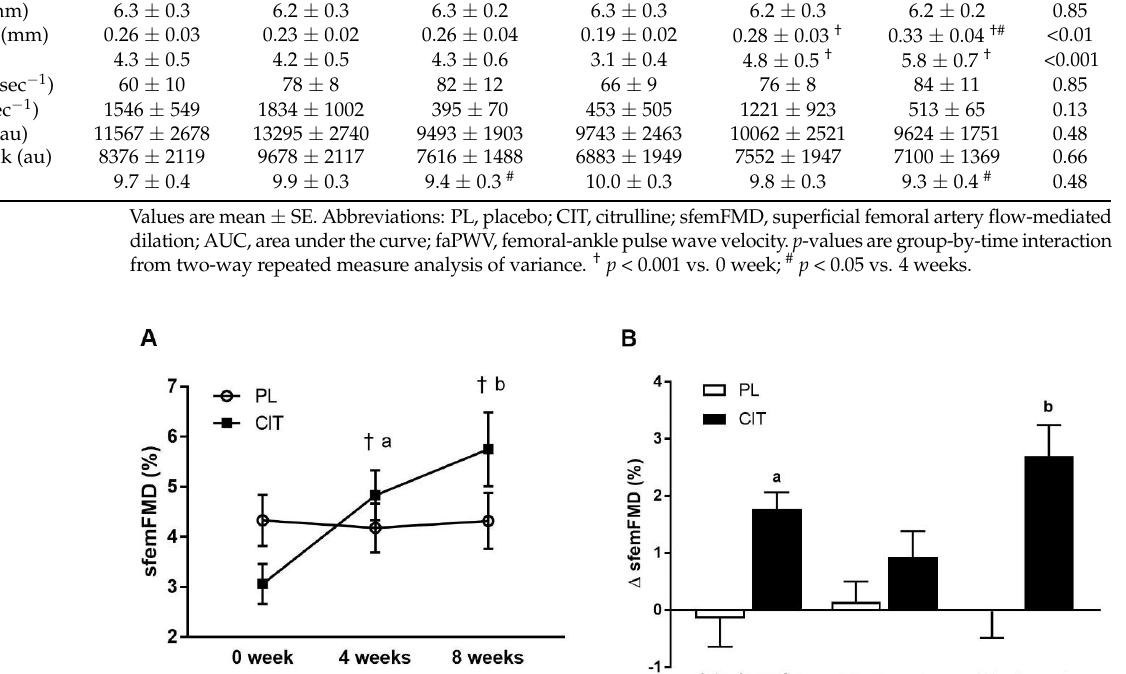
Figure 3. Superficial femoral artery flow-mediated dilation (sfemFMD) ( A ) at 0 week, after 4 weeks (CIT alone), and after 8 weeks (CIT and SVLIRT combined) and changes (Δ) in sfemFMD ( B ) from 0 week to 4 weeks, from 4 weeks to 8 weeks, and from 0 week to 8 weeks compared to PL in postmenopausal women. † p < 0.001 vs. 0 week; a p < 0.05 vs. PL; b p < 0.001 vs. PL.